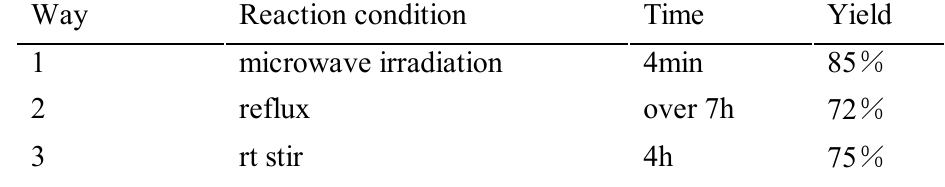
Table.1 The compare of three way of synthesis of Schiff base Way Reaction condition Time Yield 1 microwave irradiation 4min 85 ％ 2 reflux over 7h 72 ％ 3 rt stir 4h 75 ％ Melting Point: